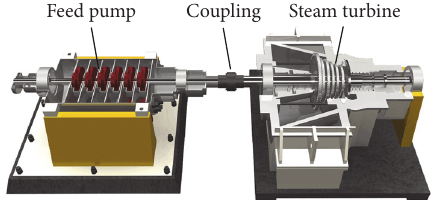
Figure 5: Internal structure of the steam turbine feed pump.